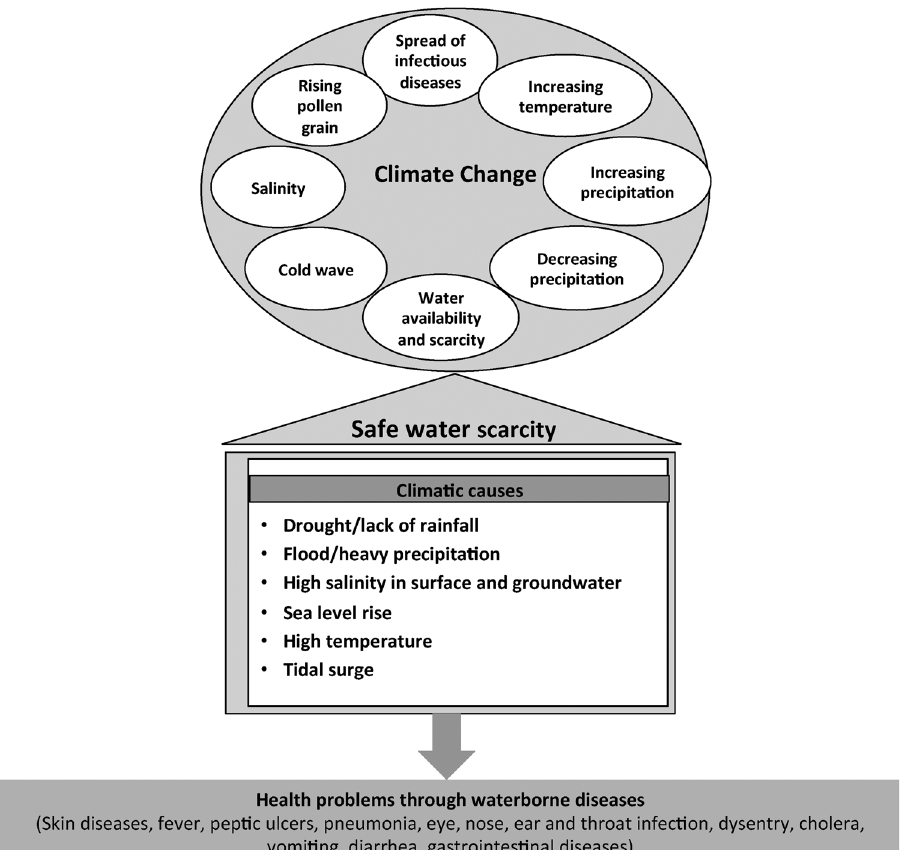
Fig. 8 Sources of drinking water in the two study villages of southwestern coastal